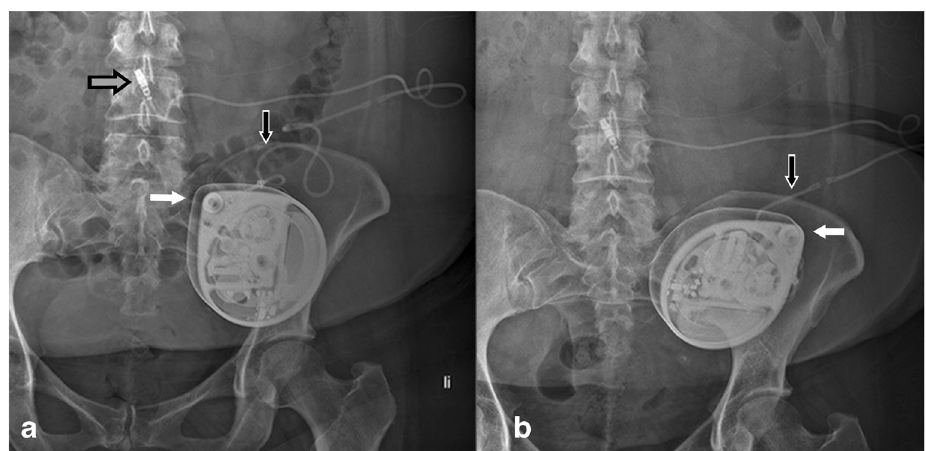
Fig. 4 Reel syndrome with signs of withdrawal syndrome in a 52-year-old woman with dystonia in CRPS. The apex of the pump is turned from the 11 o ’ clock to 2 o ’ clock position ( white arrow ). Because of the visible traction on the catheter ( black arrow ), the pump must be rotated several times about the horizontal axis